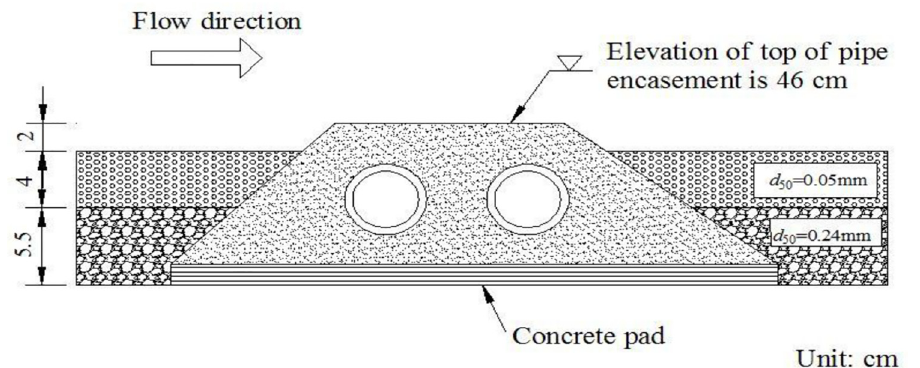
Fig 3. Longitudinal cross-section of the initial bed near a trapezoidal